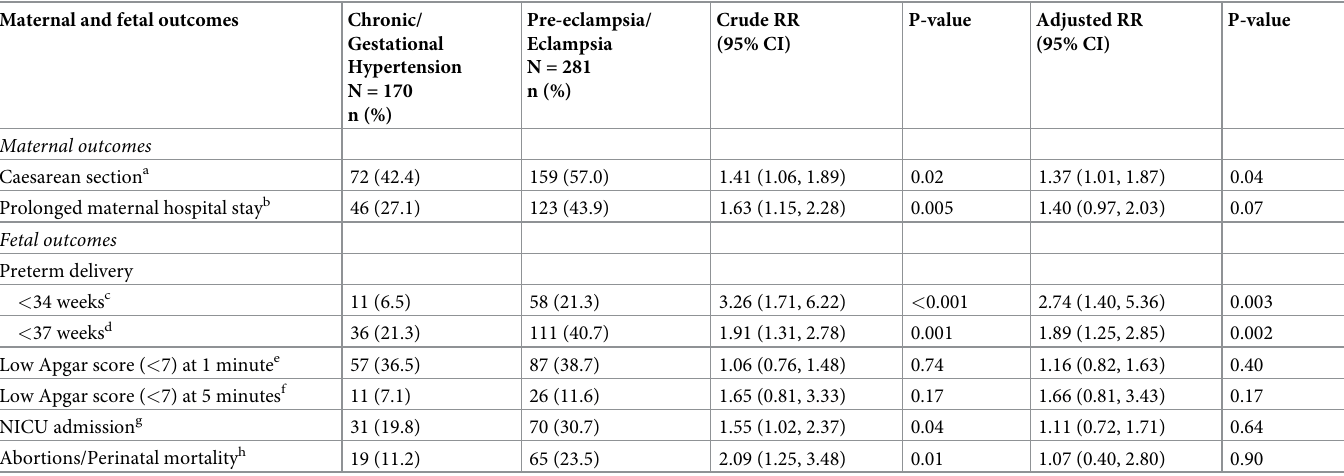
Table 4. Adverse maternal and fetal outcomes of women with pre-eclampsia/eclampsia compared to women with chronic/gestational